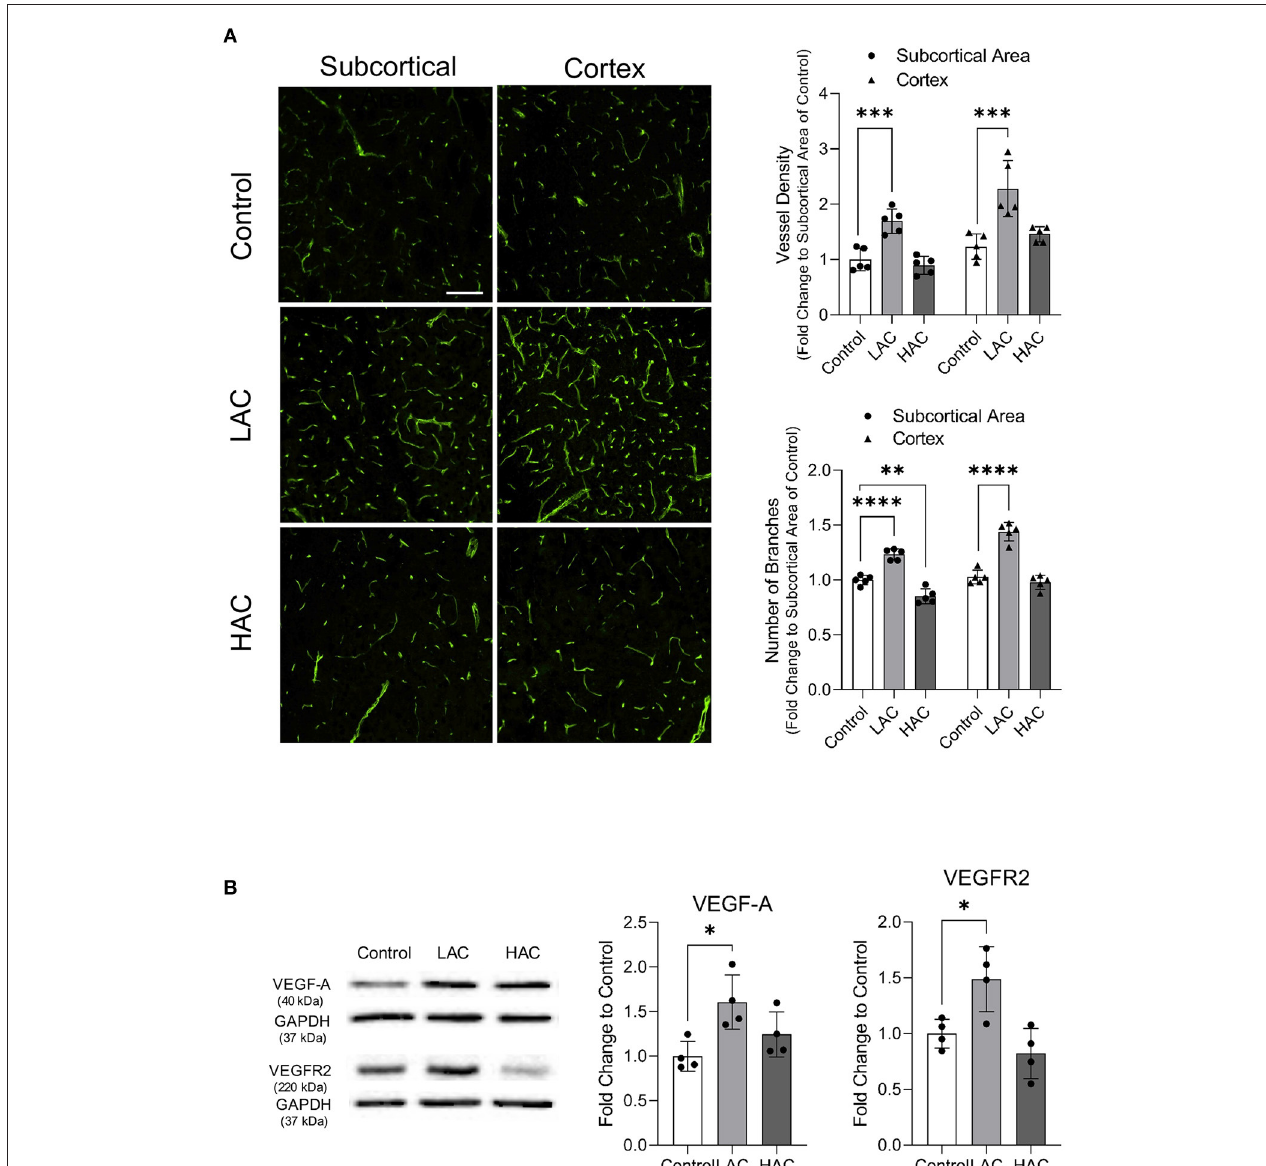
FIGURE 3 | Effect of chronic alcohol consumption on cerebral angiogenesis under physiological conditions. (A) Representative images of CD31 staining (left). Values are means ± SD (right, n = 5). (B) Representative Western blots of VEGF-A and VEGFR2 (left) (scale bar = 100 µ m). Values are means ± SD (right, n = 4). * P < 0.05, ** P < 0.005, *** P < 0.0005, **** P < 0.0001 vs. Control. Analyzed using one-way ANOVA with Dunnett’s post-hoc